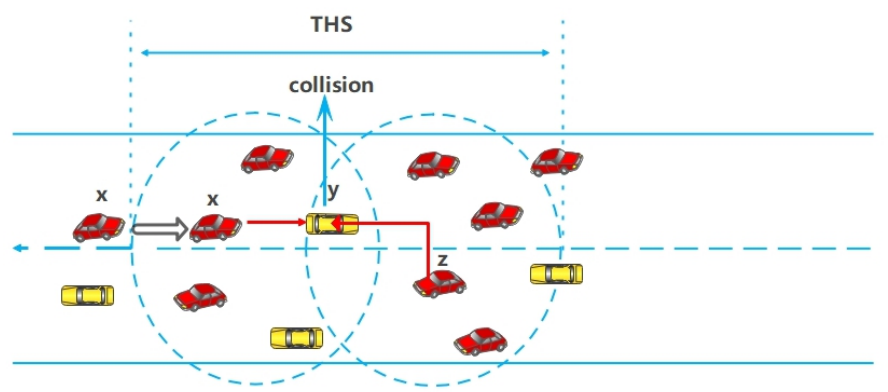
Figure 4. Vehicle communication in balanced traffic flow scenario.